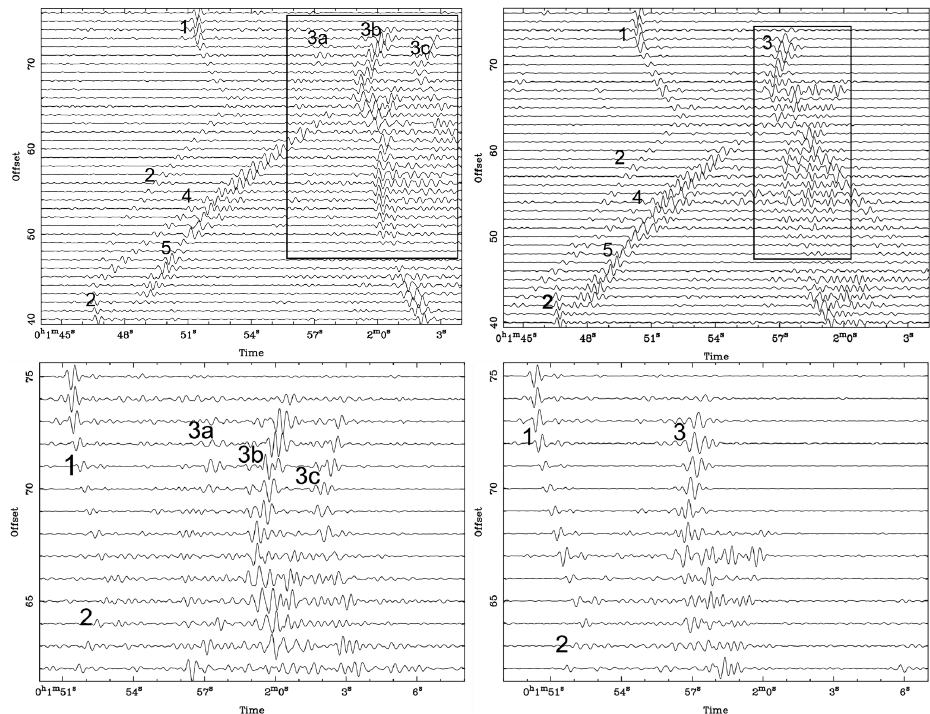
Fig. 13: Time-reduced synthetic record sections for a double-couple source at 108 km depth showing S waves. Left panel: model with DSC. Right panel: model without DSC. Marked phases: (1) direct S wave, (2) S wave refracted at slab interface, (3) guided wave, (3a–c) multiple guided waves in model with DSC, (4) SP surface conversion refracted at slab interface, (5) SP surface conversion reflected at slab interface. Phases 1, 2, 4 and 5 appear in models with and without DSC. Note the three distinct guided waves in the model with DSC. Boxes enclose signals related to guided waves. Lower panels: zoom into the receiver range 62 to 75 where the three guided arrivals are best